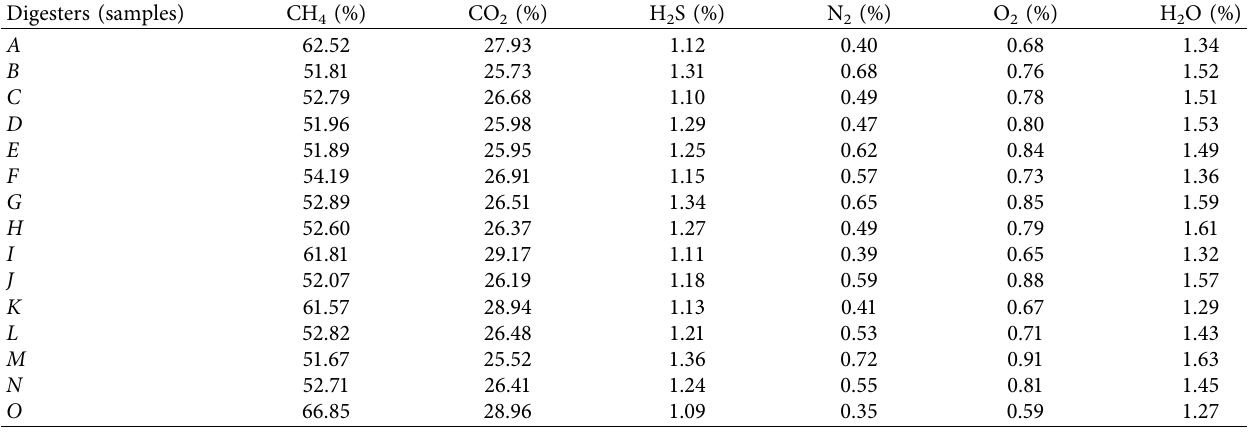
Table 5: Constituents’ analyses of biogas samples [38].